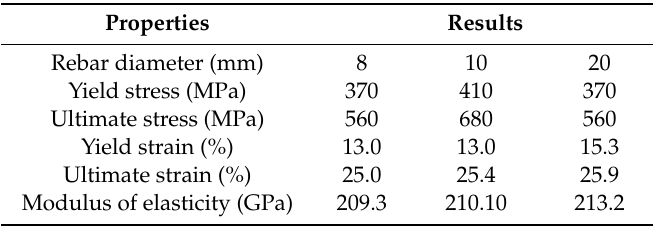
Table 3. Rebar test